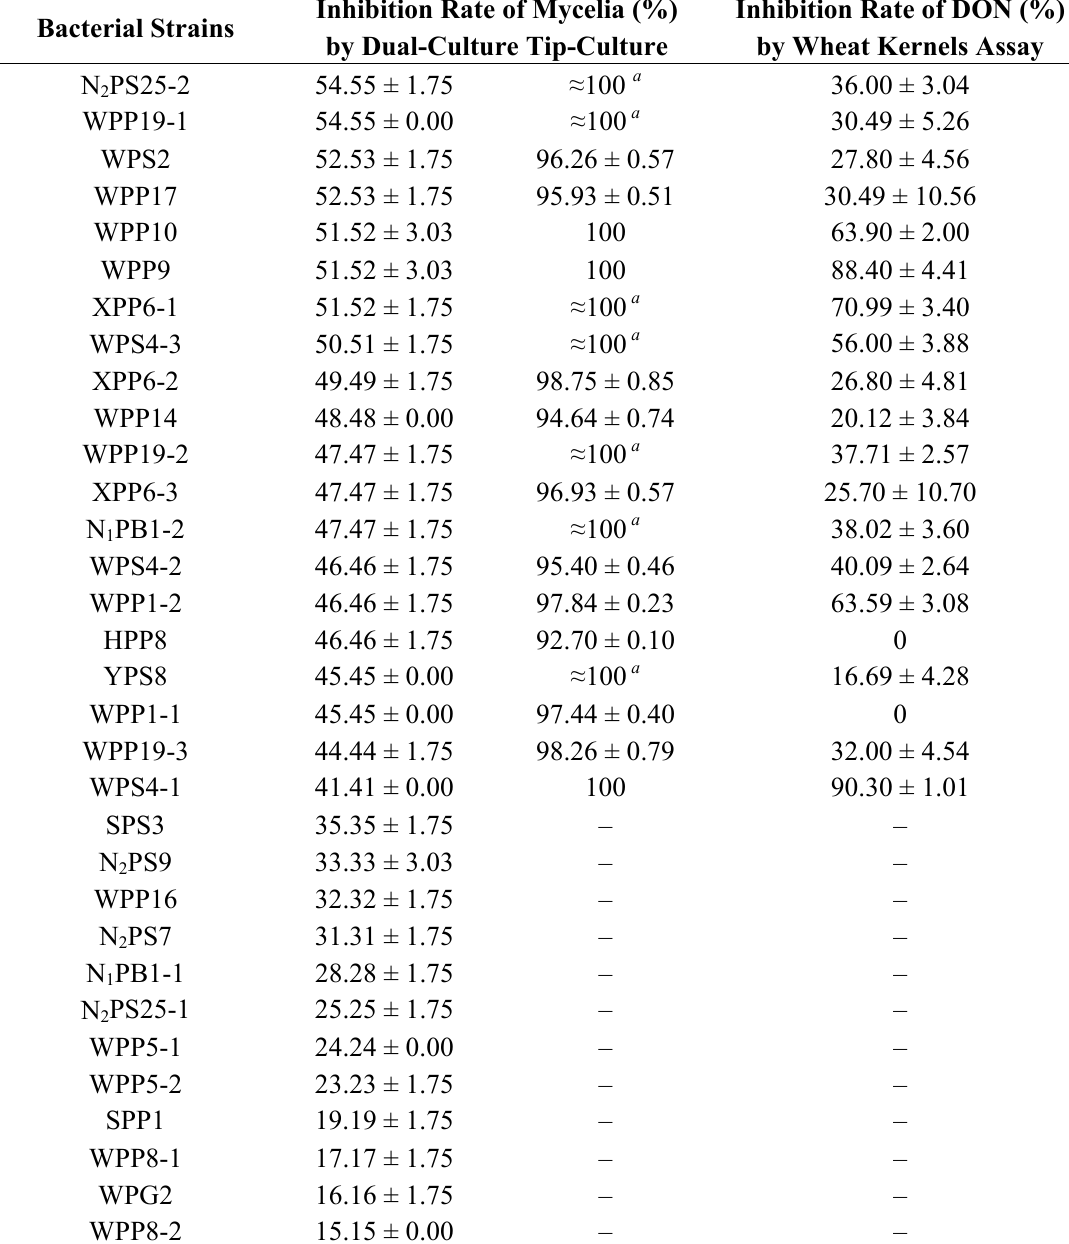
Table 1. Antifungal activities of bacterial strains against F. graminearum growth in the dual-culture and tip-culture assays and against DON production in wheat kernels assay. Bacterial